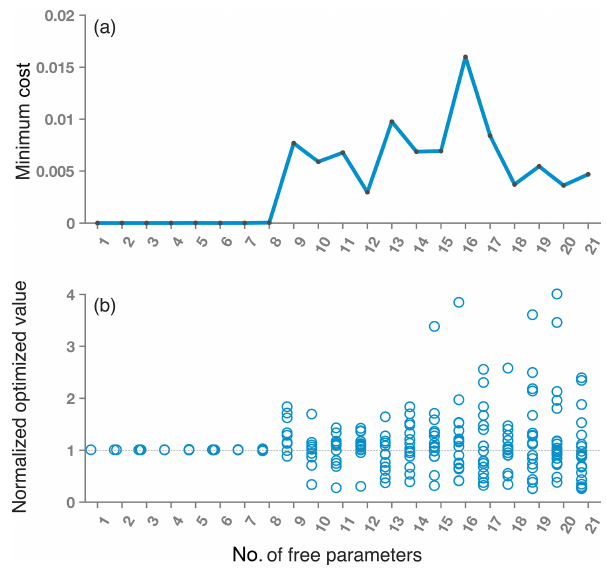
Figure 3. (a) Minimum costs and (b) normalized parameter val- ues in numerical twin experiments, illustrating that the assimilation procedure is unable to successfully recover the true parameter val- ues when more than eight parameters are optimized. One data point in three of the experiments (19, 20, and 21) exceeds the y axis upper limit in panel (b)